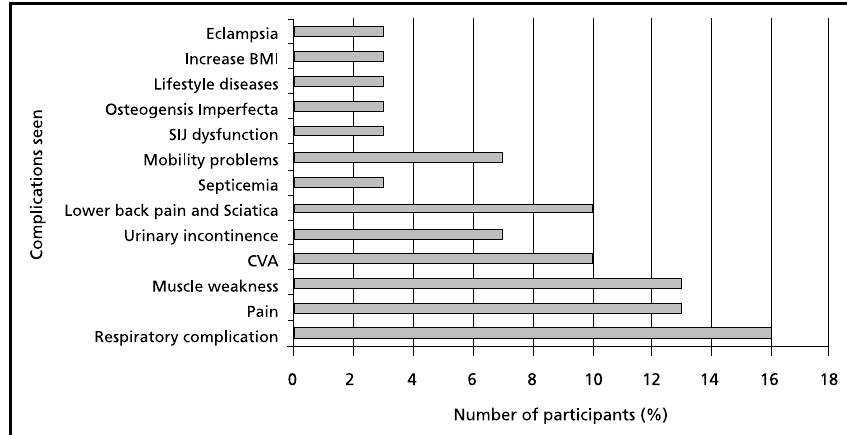
Figure 3: complications seen by Physiotherapists